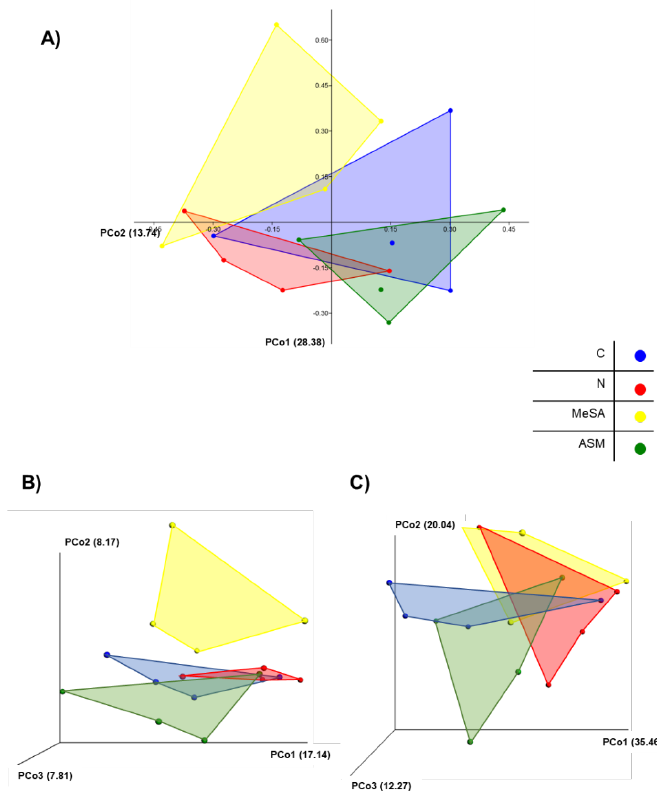
Figure 2. Principal coordinate analysis (PCoA) of the ( A ) Bray-Curtis, ( B ) unweighted UniFrac, and ( C ) weighted UniFrac distances from pine rhizosphere microbiome samples. C, negative control; N, nematode-inoculated; MeSA, nematode-inoculated after treatment with methyl salicylic acid; ASM, nematode-inoculated after treatment with